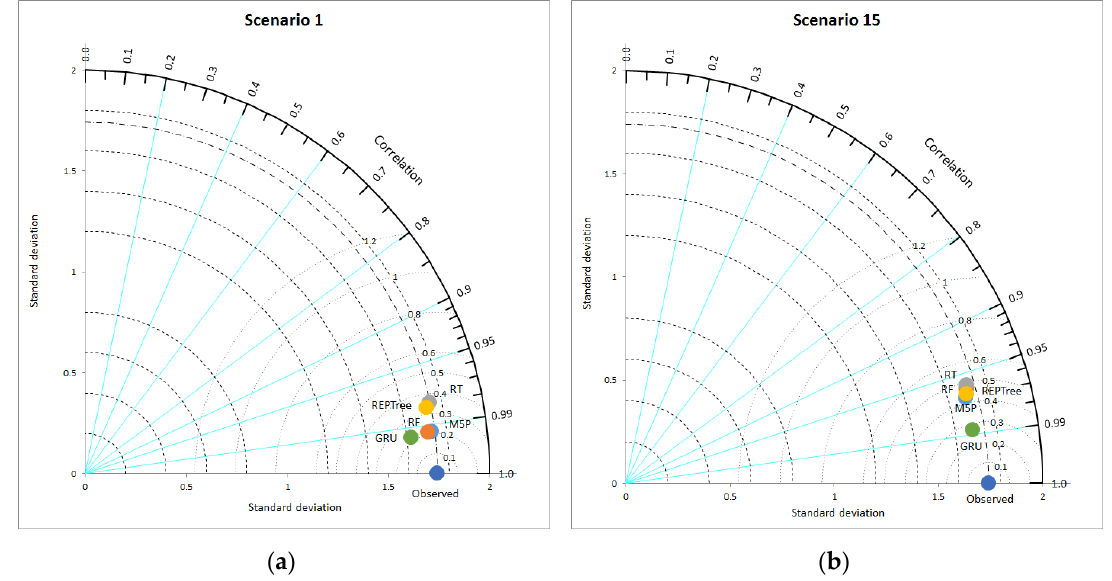
Figure 12. Taylor diagrams for ETo estimations based on used models ( a ) Scenario 1 and ( b ) Scenario 15.